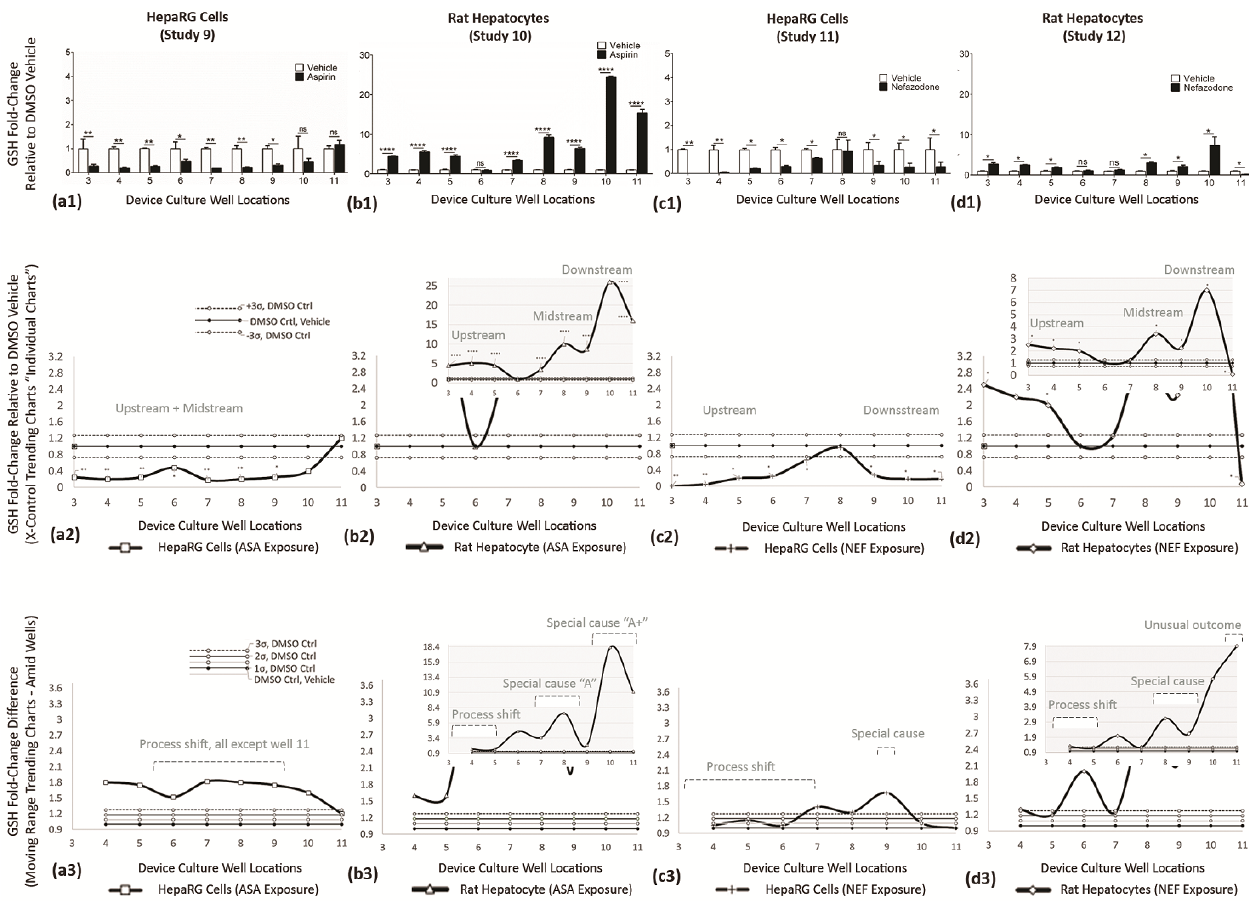
Figure 12. GSH levels across multiwell culture locations at Day 7. GSH synthesis shown as fold changes (vertical axis) vs. DMSO vehicle control; vehicle normalized at 1. ( a1 , b1 ) Effect of aspirin exposure in HepaRG cells and rat hepatocytes. ( c1 , d1 ) Effect of nefazodone exposure in HepaRG cells and rat hepatocytes. ( a2 , b2 , c2 , d2 ) Re-expression of data using individual trending charts (i.e., X control charts) to convey DMSO controls with drug study outcomes. ( a2—HepaRG line graph ) ASA inhibits GSH activity across wells 3 (**)–9 (*). ( b2—rat hepatocyte line graph ) ASA promotes GSH synthesis in upstream wells 3 (****)–5 (****), displays normal function in well 6, then stimulates GSH functions in wells 7 (****)–11 (****). ( c2—HepaRG line graph ) NEF inhibits GSH activity across wells 3 (*)–7 (*) and wells 9 (*)–11 (*). ( d2—rat hepatocyte line graph ) NEF promotes GSH